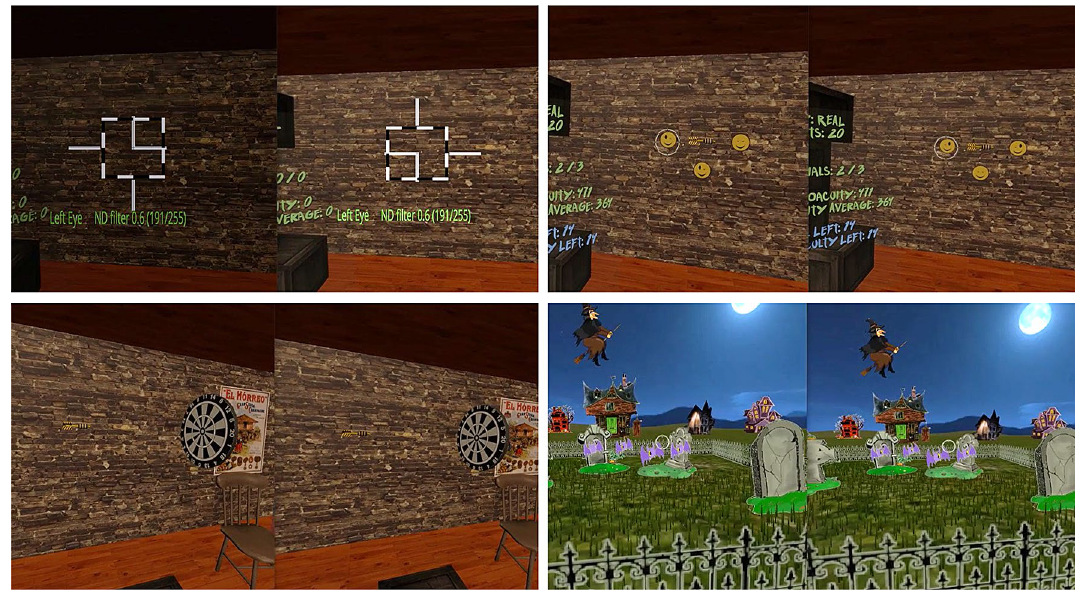
Figure 10. DartBoard and Halloween game screenshots. Top left: Fusion-lock frame calibration for DartBoard (similar in Halloween) to eliminate subjective misalignment angles. Top right: DartBoard 3-AFC suppression task. Bottom left: DartBoard trial example. Bottom right: Halloween trial